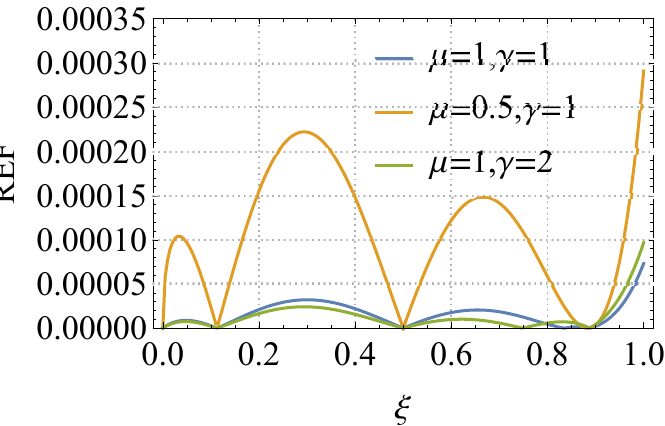
Figure 6. Graph of the of the residual error function (REF) of the approximate solution of Model 3, with α 2 = 2.7, α 1 = 0.7, T = 1, m = 5 and τ = 0.00001, and for different values of µ and γ